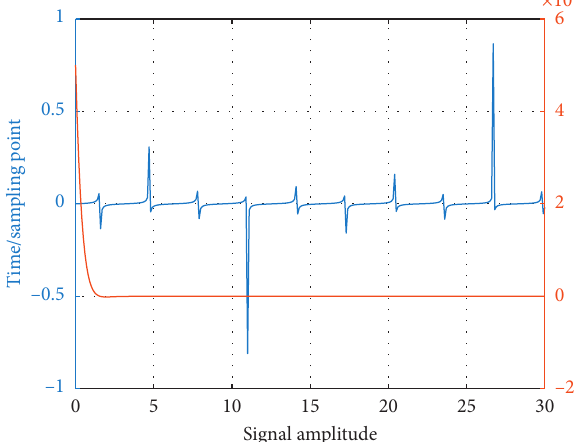
Figure 4: Music file theme extraction